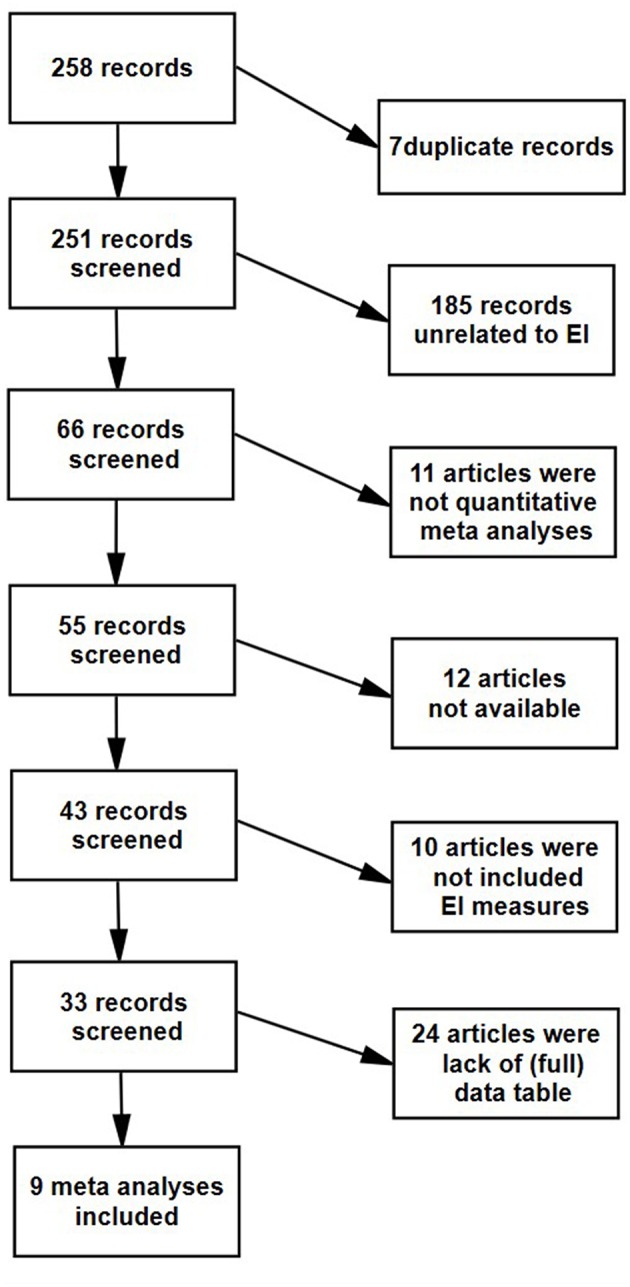
A schematic overview of the exclusion criteria and meta-analysis selection.